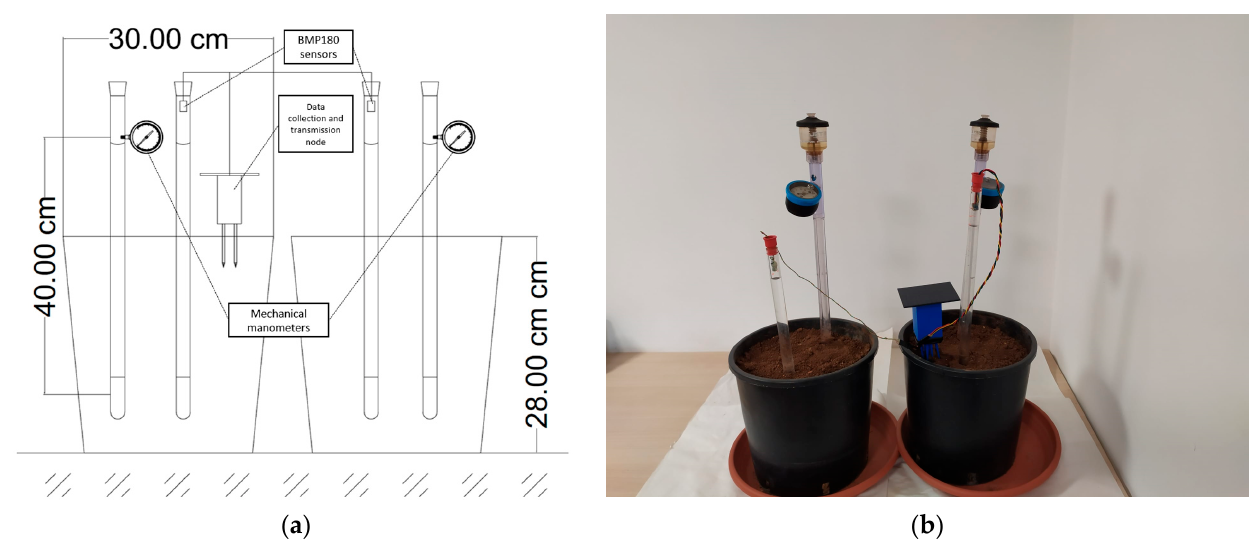
Figure 4. Validation setup: ( a ) Designed sketch; ( b ) in the lab.